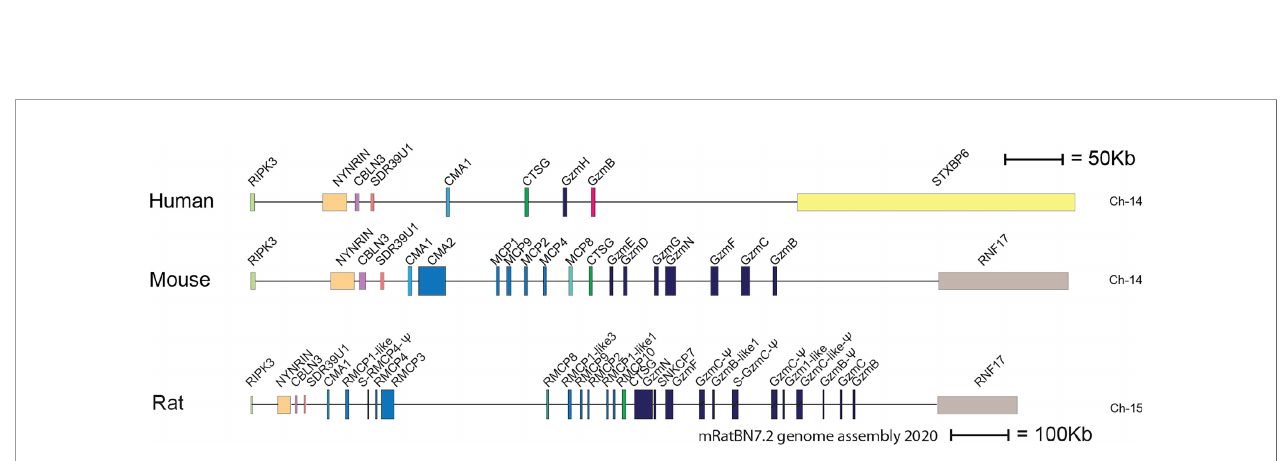
FIGURE 1 | Nomenclature of the amino acids surrounding the cleaved peptide bond and the amino acids forming the active site pocket. Panel A shows the amino acids N-terminal from the cleaved bond are termed P1 (where cleavage occurs, depicted by scissors), P2, P3 etc. Amino acids C-terminal of the cleaved bond are termed P1 ’ (adjacent to P1), P2 ’ , P3 ’ etc. The corresponding interacting sub-sites in the enzyme are denoted with S. Panel B shows the S1 pocket, which is important in determining the primary speci fi city of the chymotrypsin family. The important residues are shown, which determine chymotrypsin-, trypsin- or elastase-like speci fi city. Three residues corresponding to positions 189, 216 and 226 in bovine pancreatic chymotrypsinogen has been found to be the amino acids forming the major part of this pocket and thereby giving the primary speci fi city of the enzyme